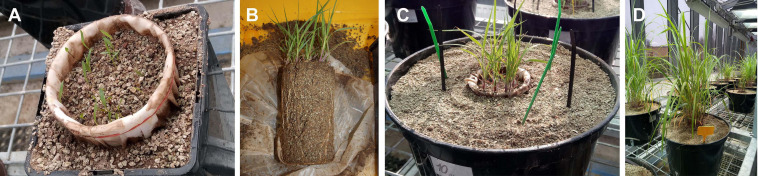
Plant root compartments for Experiment 1 lined with root-barrier mesh and placed in 2 L pots at 1 week after seeding (A) and the root development of the plants at 4 weeks after the seeding (B). Experimental containers of Experiment 1 just after settling in the plant compartments pre-grown for 4 weeks, and the different (organic and mineral) nitrogen traps in 10 L pots (C), and after further 8 weeks of growth just before the destructive harvest (D).